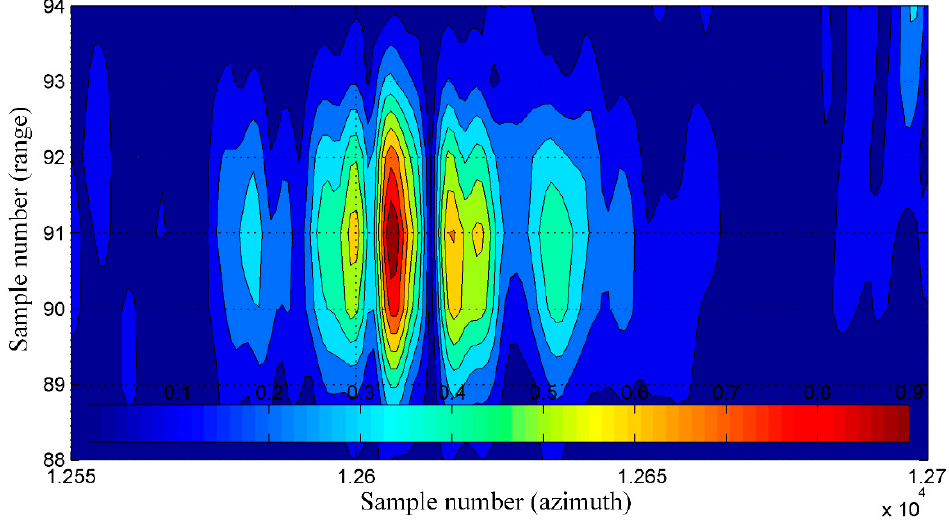
Figure 14. The normalized amplitude of the selected corner reflector pixels—the INS/GPS-based MOCO.